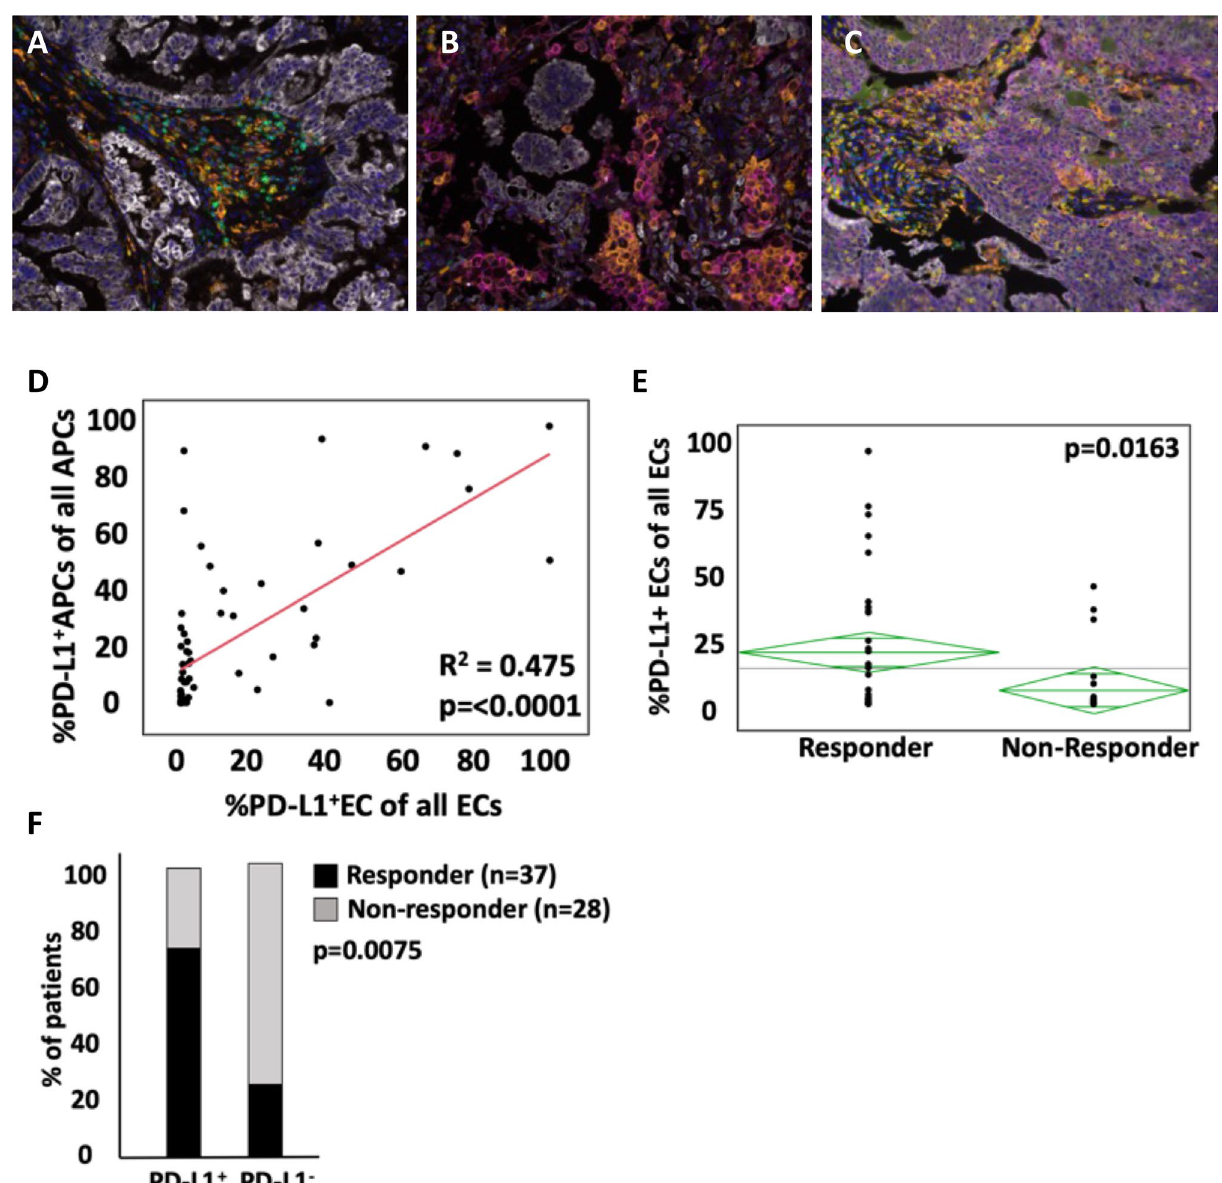
Figure 1. PD-L1 staining patterns on tumor cells and antigen presenting cells. 3 distinct patterns of PD-L1 expression are noted: ( A ) no PD-L1 expression ( B ) primary expression on APCs (magenta) and ( C ) primary expression on tumor cells (light purple). ( D ) positive correlation between APC and EC PD-L1 expression. ( E ) lower EC PD-L1 expression in non-responders compared to responders. ( F ) EC PD-L1 expression in responders and non-responders, with significantly more non-responders in the PD-L1 − group. All images are obtained at 20 ×